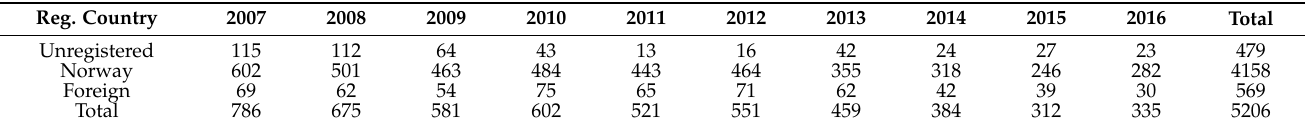
Table 3. The number of HGVs involved in police-reported traffic accidents involving personal injuries in Norway 2007–2016 by country of registration.